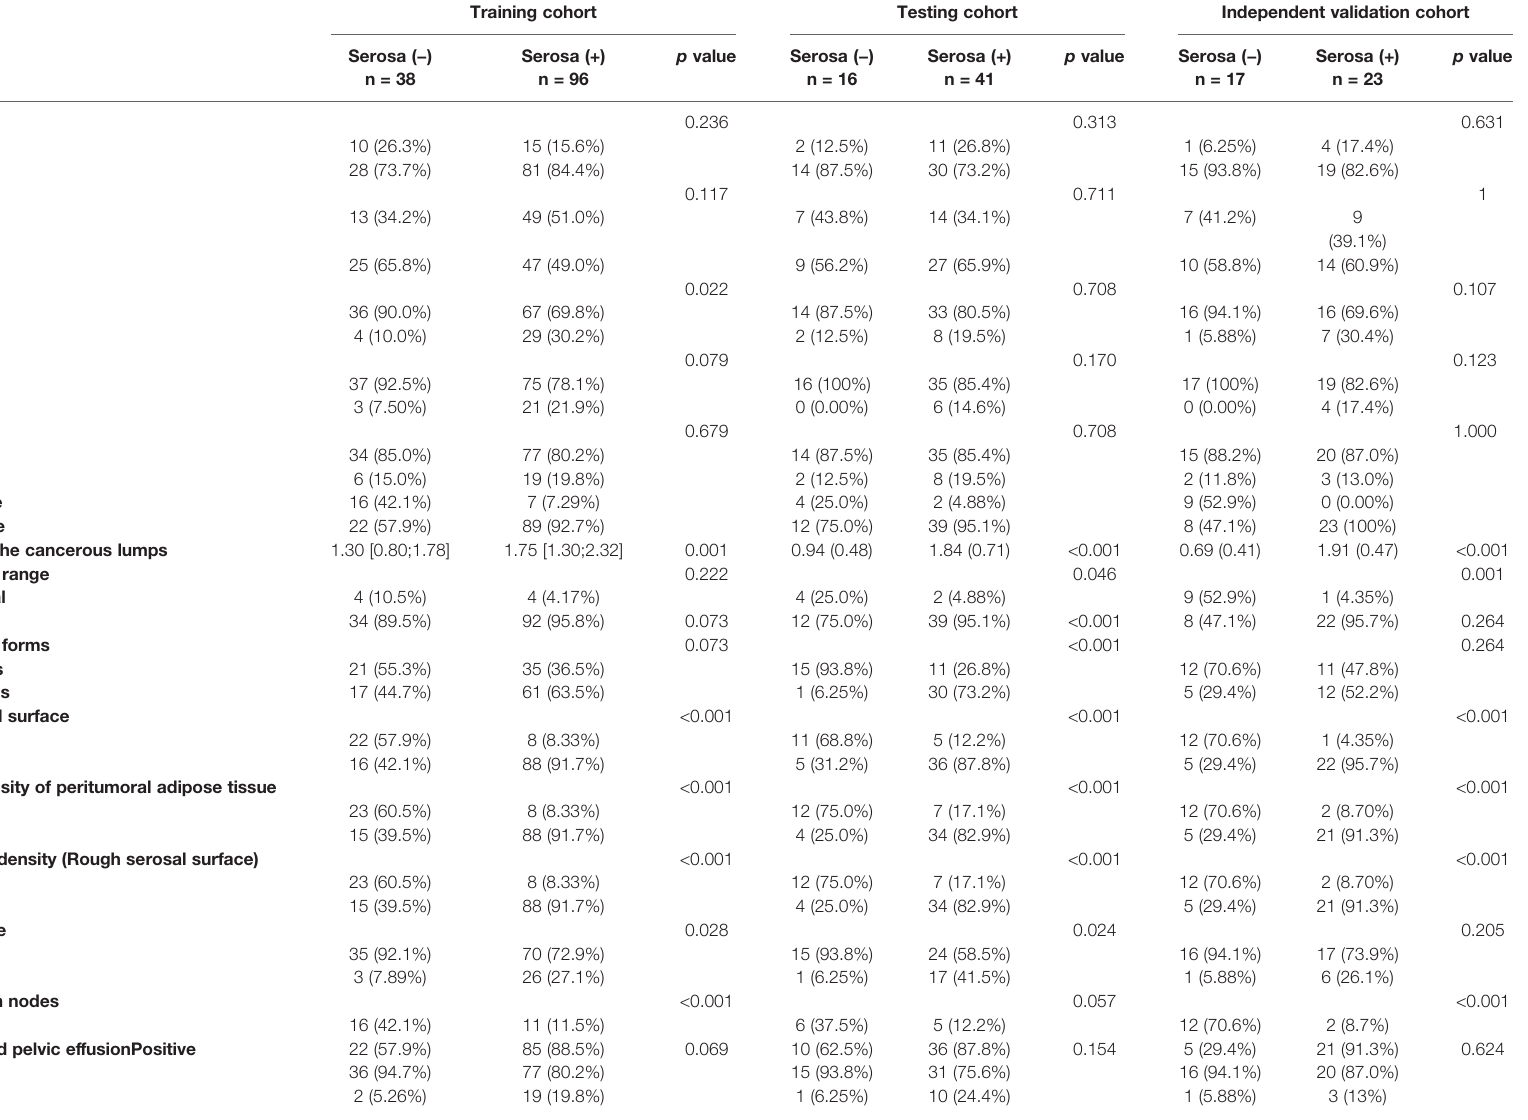
TABLE 1 | Clinical and semantic features of the